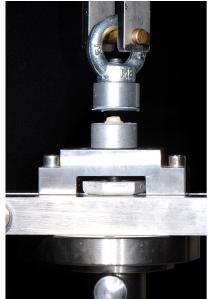
Figure 1. Design of retention strength measurement.